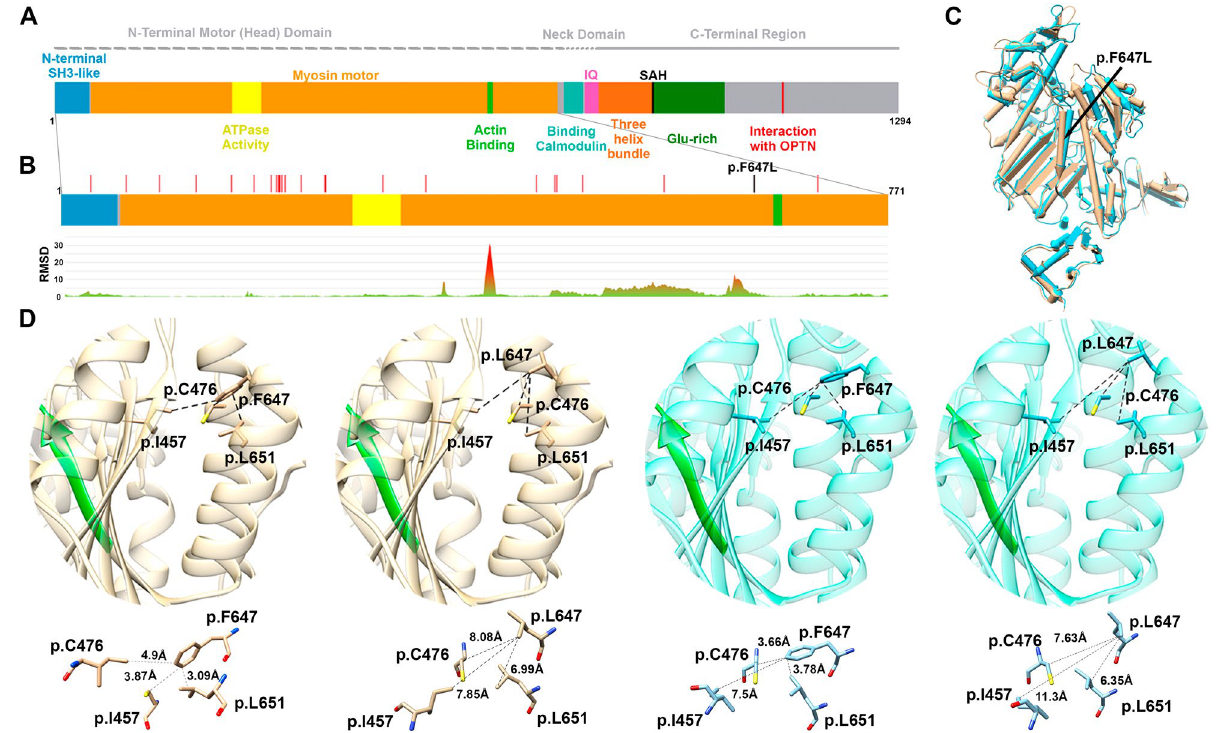
Figure 3. Motor head domain analysis of MYO6 protein. ( A ) Ideogram of MYO6. ( B ) RSMD analysis of the motor head domain shows peaks with high RMSD values, revealing that two areas (one including the p.(F647L)) are involved in regions with great motility between pre-powerstroke and Pi release conformations. ( C ) Motor head domain modeling. Pre-powerstroke conformation in light blue and Pi release in brown. The p.(Phe647Leu) is shown with a black arrow. ( D ) Zoom in of the alpha-helix at the 647 region. The interaction of the wild- type Phe647 residue or the mutated version Leu647 with the three nearest residues is shown for each protein conformation (Pi release in brown and pre-powerstroke in light blue). The β-strand in green represents the actin binding region. Distances in Å are detailed under each bubble, showing the increase in the distances for the mutated Leu647 residue in both